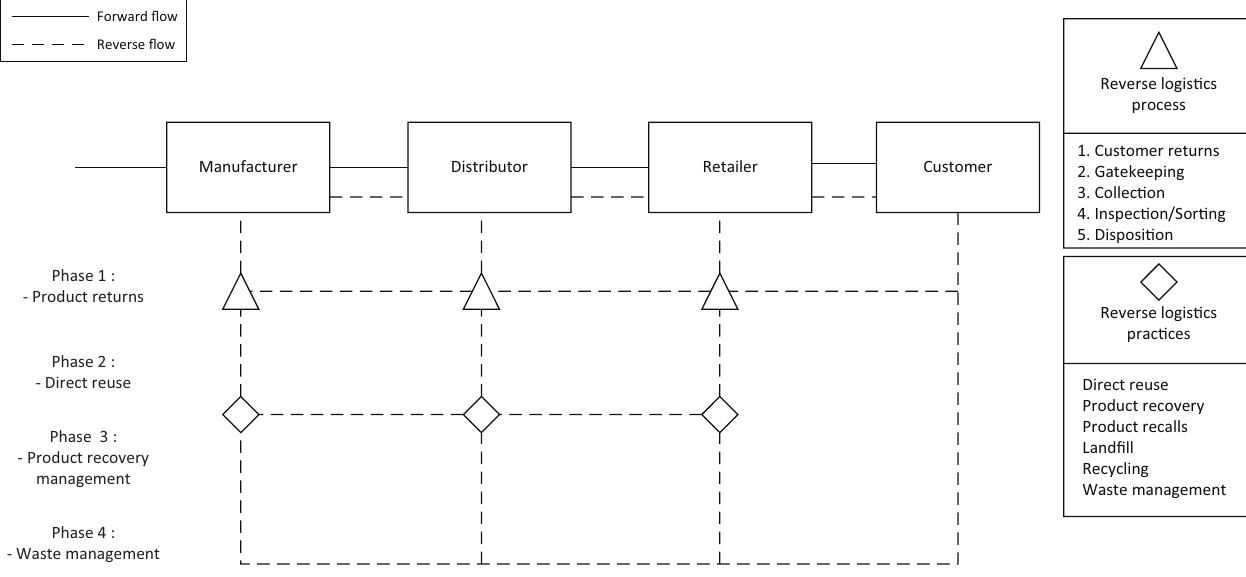
FIGURE 1: Reverse logistics